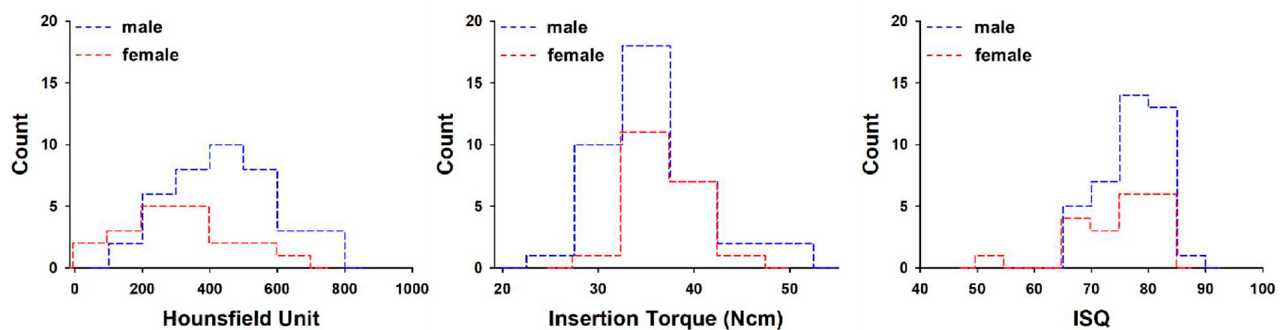
Figure 3. Histogram of average Hounsfield units, maximum insertion torque, and implant stability quotient values with patient gender. ISQ = implant stability quotient.